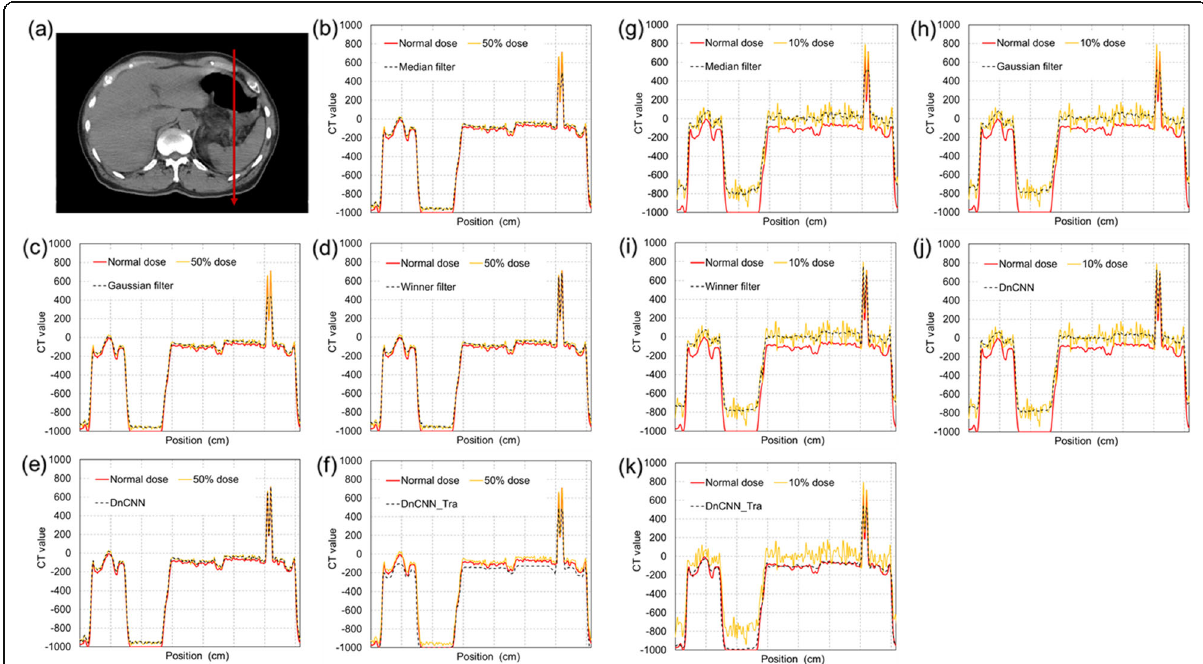
Fig. 4 Comparison of the vertical profiles in each image. a Profile position; b-f CT value profiles along the red arrow in ( a ) with each noise reduction method in the 50% dose equivalent image; g-k CT value profiles along the same line in the 10% dose equivalent image. Red line depicts the normal dose image, yellow lines represent the dose reduction images, and each black dashed line denotes the denoised images by the Median, Gaussian, Winner, original DnCNN and DnCNN_Tra techniques,